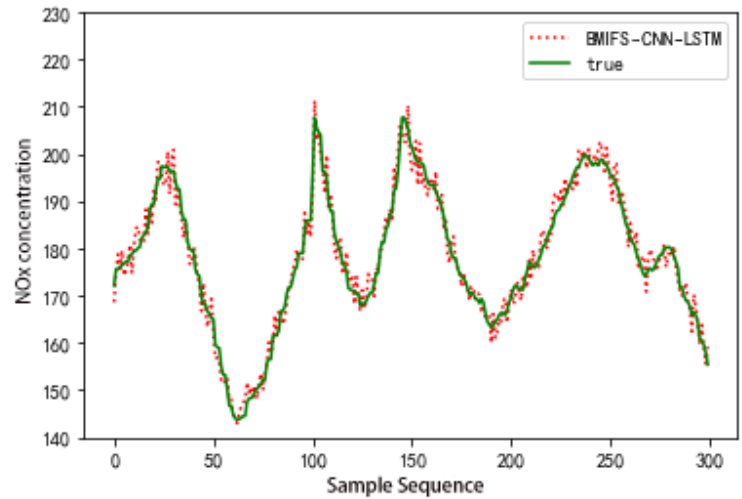
Table 3. Comparison table of simulation results.